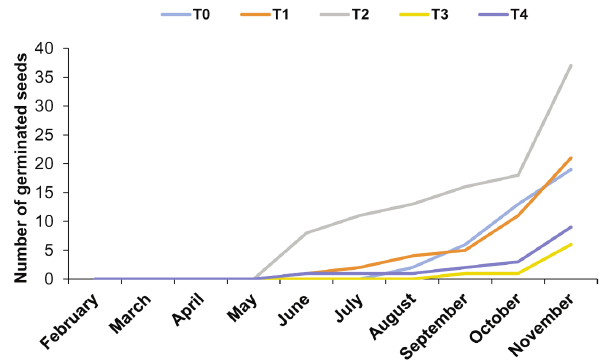
Fig. 4 ­ Effect of different warm stratification treatments on the kinetic of germination of Cycas revoluta